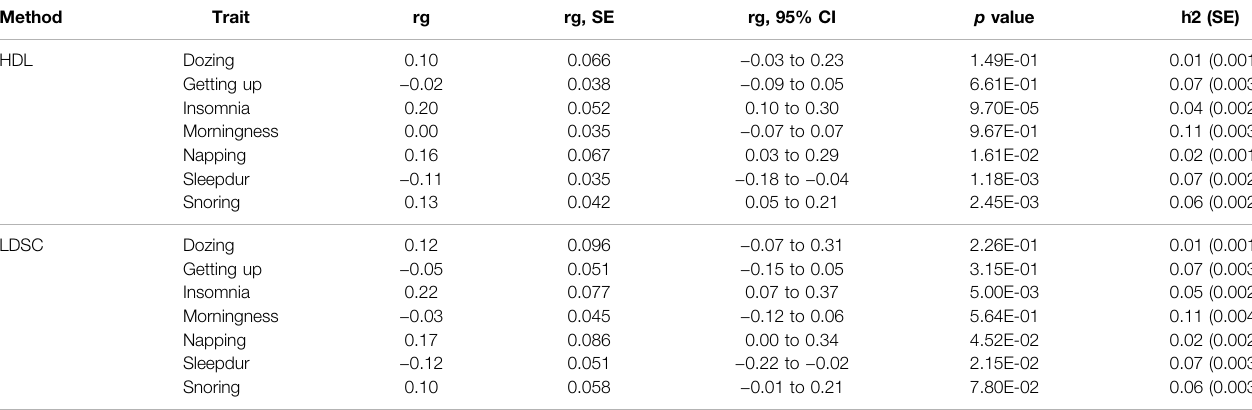
TABLE 1 | Genetic correlation of Alzheimer ’ s disease with related sleep-related phenotypes estimated by the high-de fi nition likelihood method and linkage disequilibrium score regression.